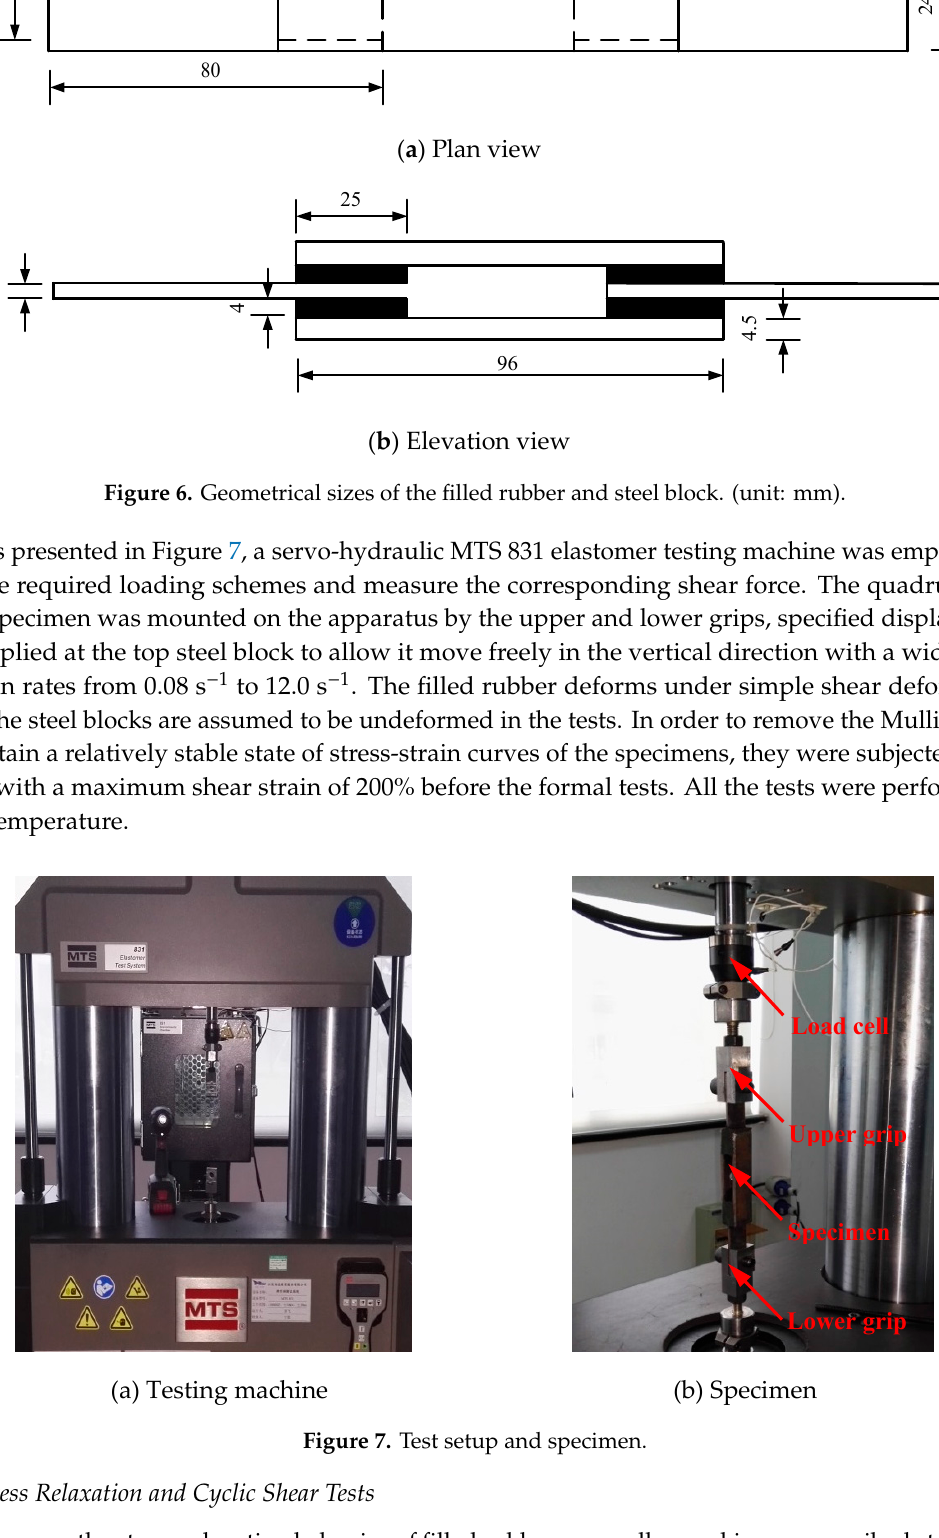
Figure 5. Illustration of the quadruple-lap shear specimen.